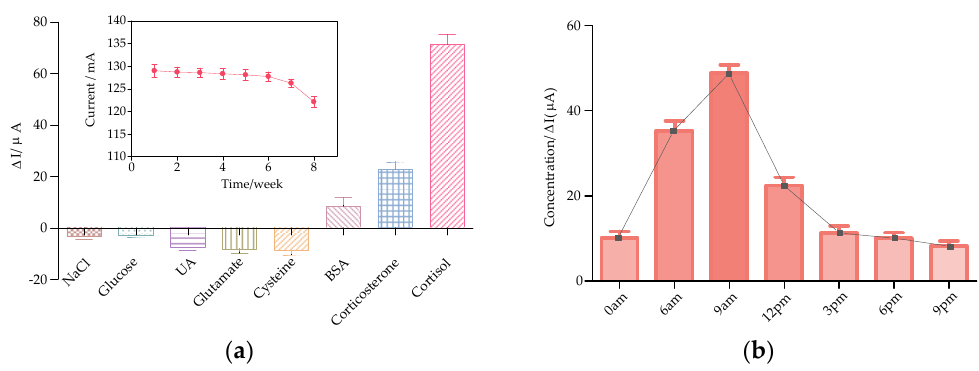
Figure 6. ( a ) Selective responses of cortisol and substances existed in saliva using the smartphone-controlled DPV system, inset shows the stability results of the immunosensor, ( b ) DPV responses of the variation of cortisol level in human saliva during a day based on the smartphone system.